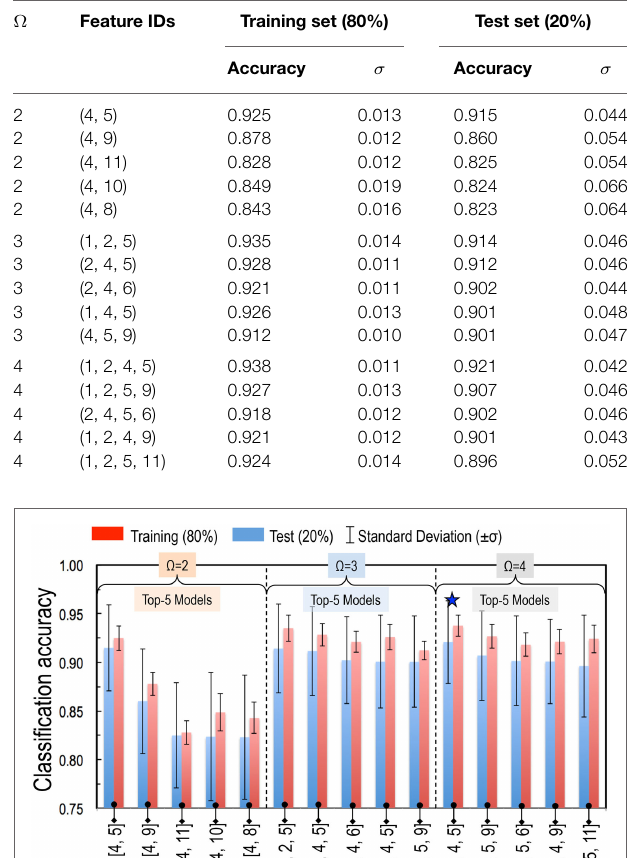
TABLE 2 | A summary of top-performing features in SVC models with varying Ω .